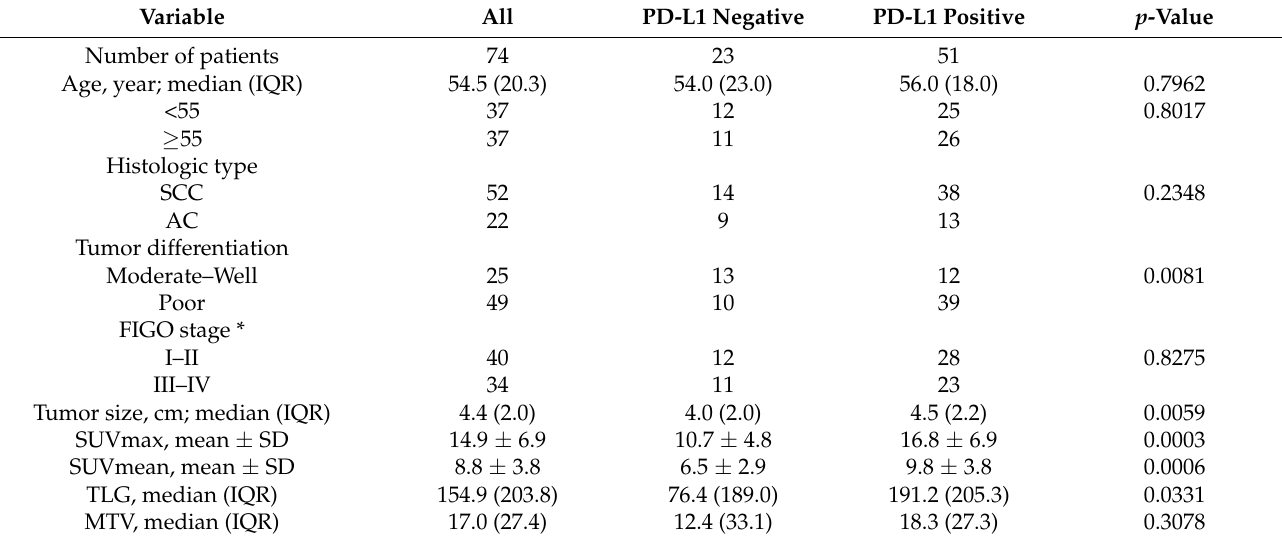
Table 1. Univariate analysis of the relationship between PD-L1 status and clinicopathologic